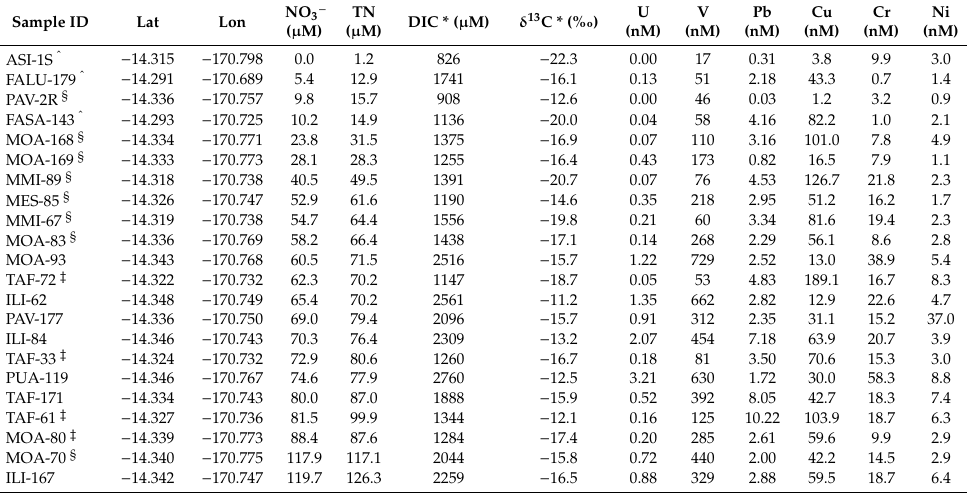
Table 1. Groundwater samples analyzed for select ions, nutrients, and trace metals (arranged in ascending NO 3 − order). Measurements for all 50 samples can be found in Table S1. The mapped sample locations can be seen in Figure 2.